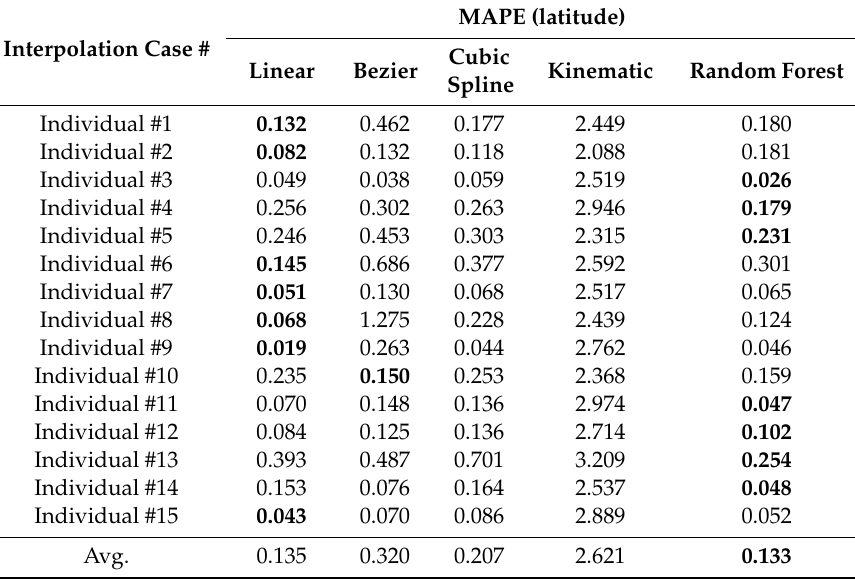
Table 4. Comparison of MAPEs for missing latitude records